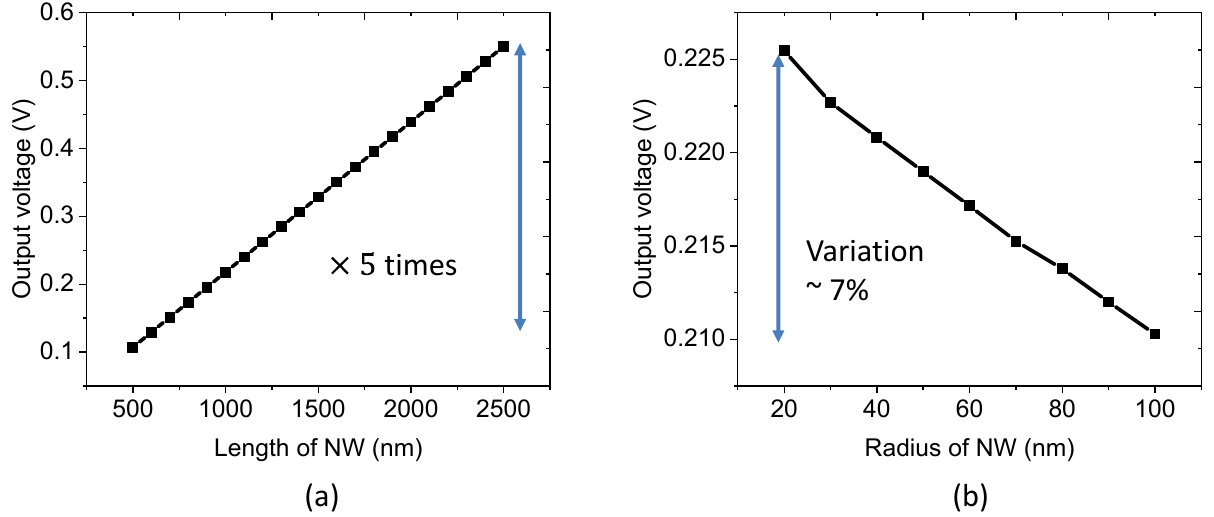
Figure 9. Effect of the ( a ) NW length, and ( b ) radius, on the generated output voltage subjected to a constant compressive stress of 1 MPa.